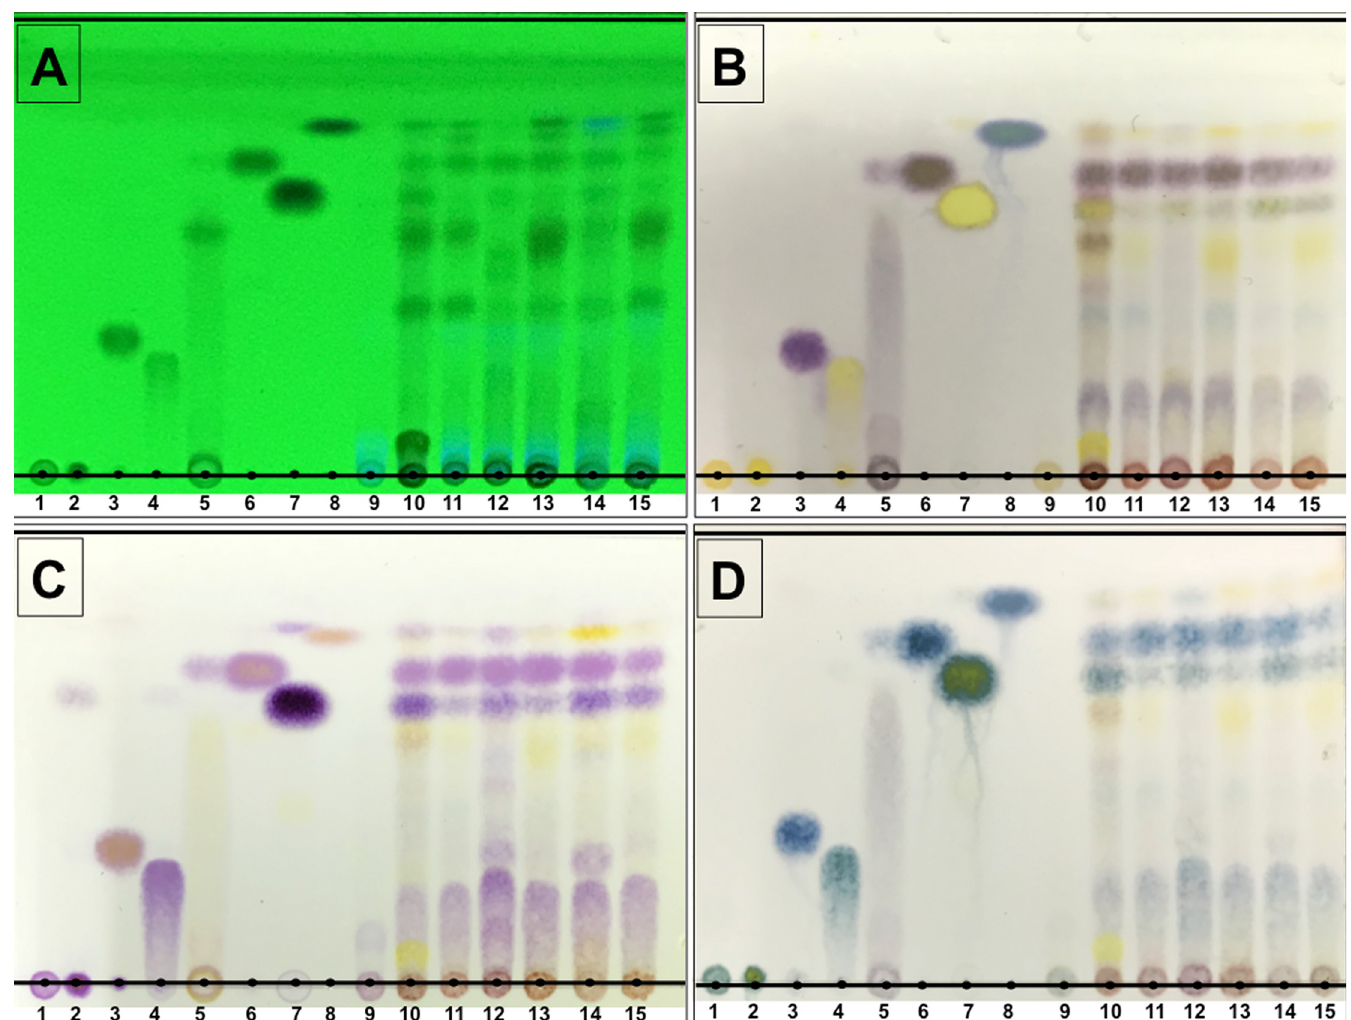
Fig 1. Identification of indole compounds produced by ectomycorrhizal fungi using thin layer chromatography technique under UV light (A), and chromogenic reaction reagents; Salkowski (B), Ehrlich (C) and Ehmann (D). Lane 1 = L-tryptophan (L-Trp), Lane 2 = tryptamine (TAM), Lane 3 = indole-3-acetamide (IAM), Lane 4 = indole-3-lactic acid (ILA), Lane 5 = indole-3-pyruvic acid (IPyA), Lane 6 = indole-3-acetic acid (IAA), Lane 7 = indole-3-ethanol (IOL), Lane 8 = indole- 3-acetonitrile (IAN), Lane 9 = uncultivated liquid medium, Lane 10 = crude culture extract of Astraeus odoratus , Lane 11 = crude culture extract of Gyrodon suthepensis , Lane 12 = crude culture extract of Phlebopus portentosus , Lane 13 = crude culture extract of Pisolithus albus , Lane 14 = crude culture extract of Pisolithus orientalis and Lane 15 = crude culture extract of Scleroderma suthepense .